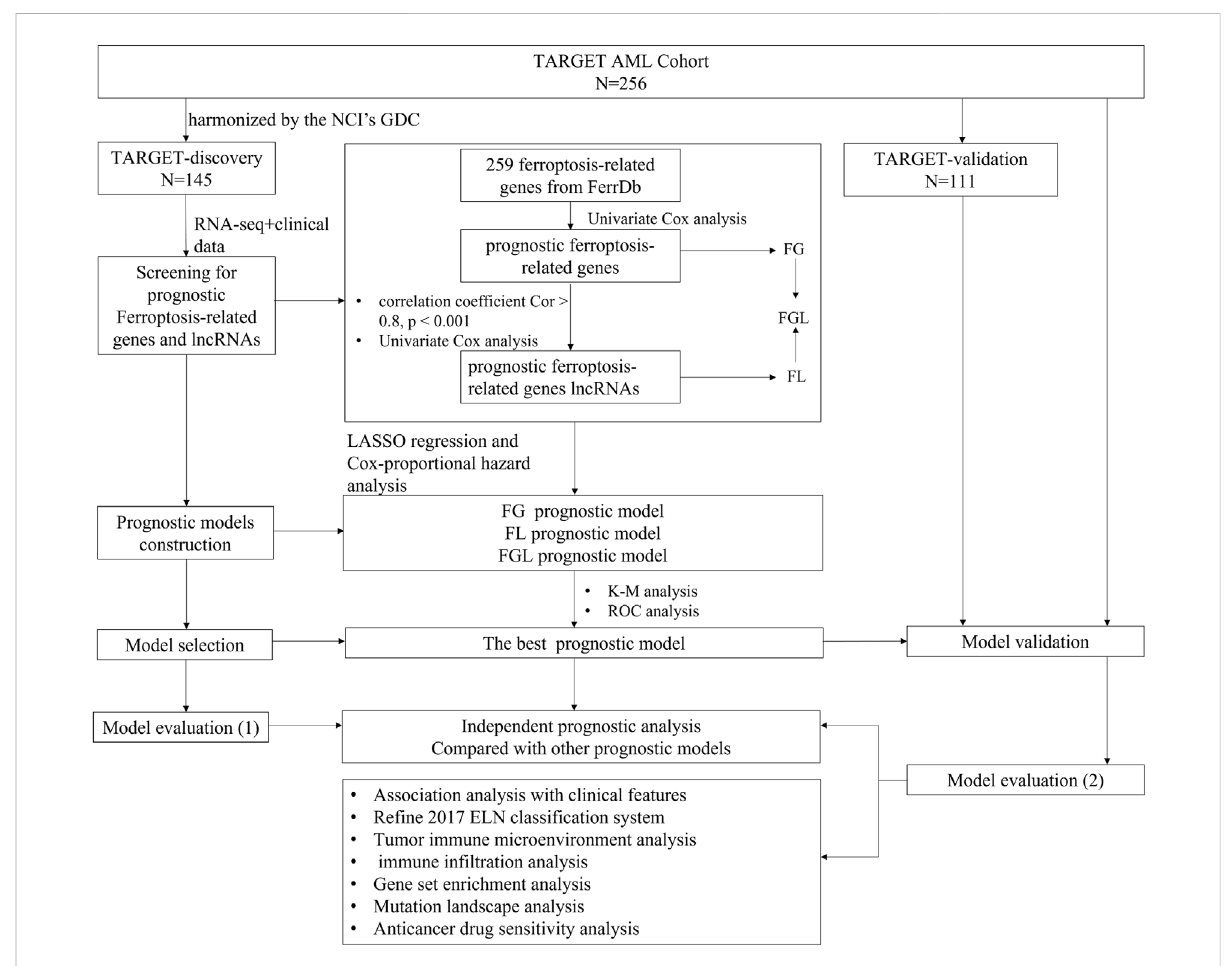
FIGURE 1 Work fl ow of this